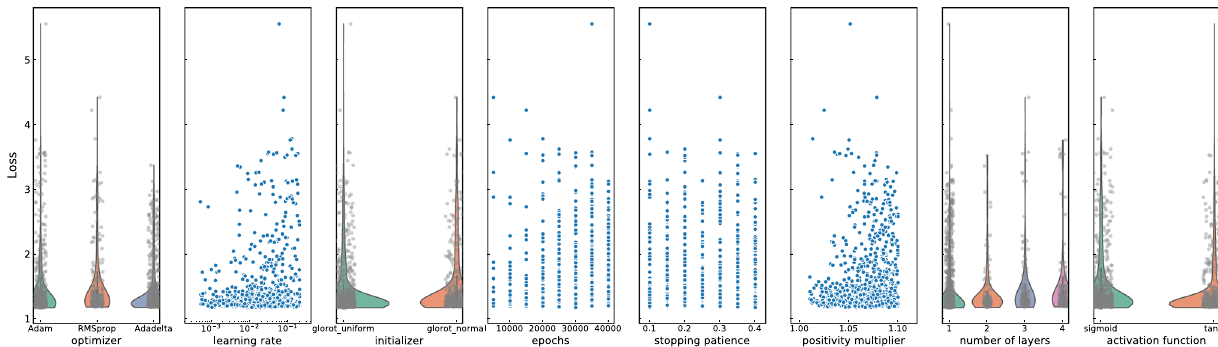
Fig. 3 Graphical representation of an hyperparameter scan for a DIS only fit with 2000 trials. The loss presented in the y-axis corresponds to an average of the validation and testing loss functions. The shape of